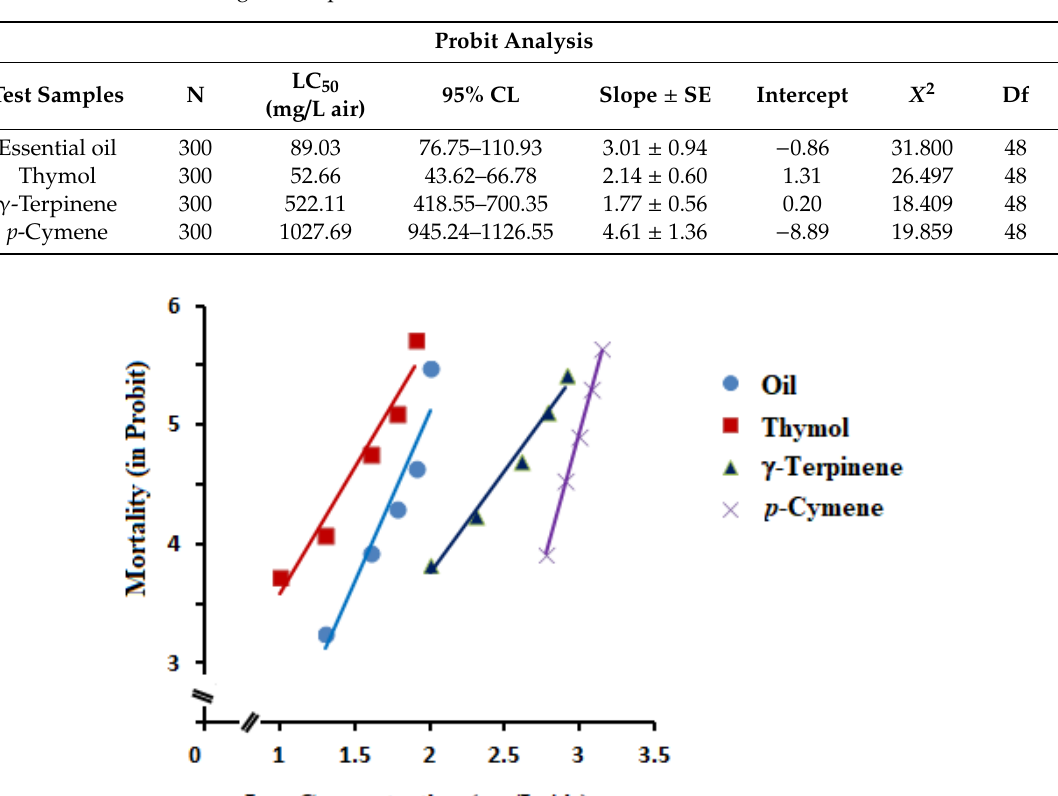
Table 3. Lethal concentration (LC 50 ) and 95% confidence limits (CL) estimated for the small hive beetles, 24 h after fumigation exposure to T. ammi essential oil and its three main constituents.